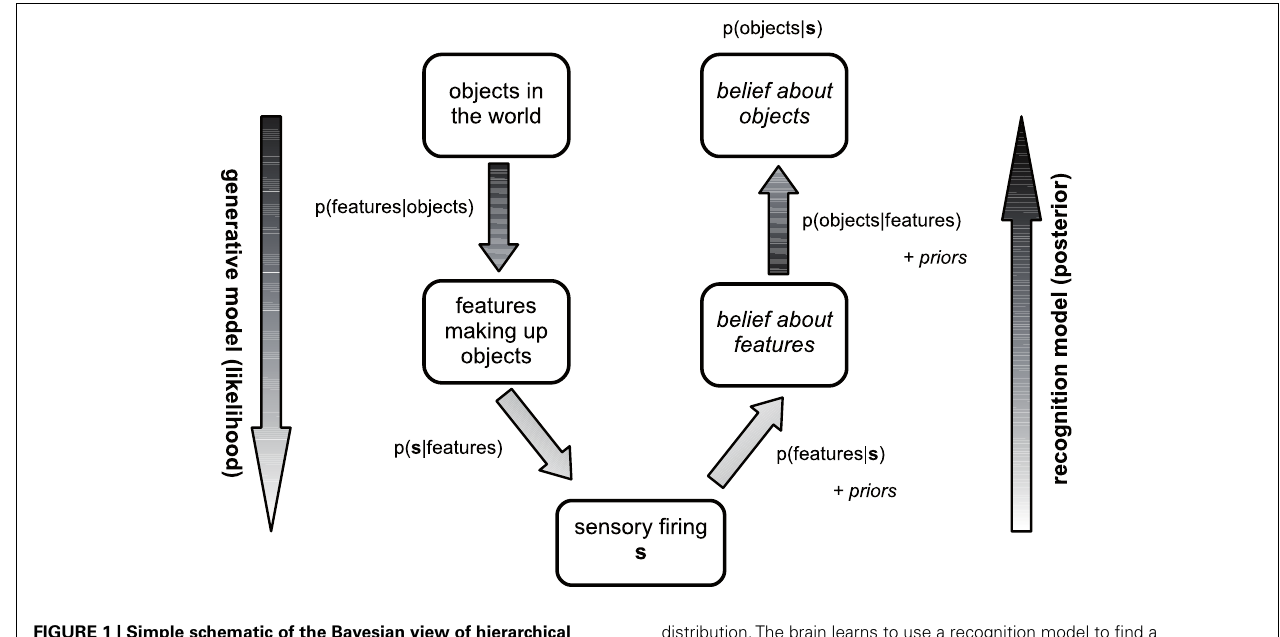
FIGURE 1 | Simple schematic of the Bayesian view of hierarchical perception. Sensory activity s is generated by a set of unknown features belonging to an unknown set of objects.The relationship between these elements in the world and s is captured by a probability